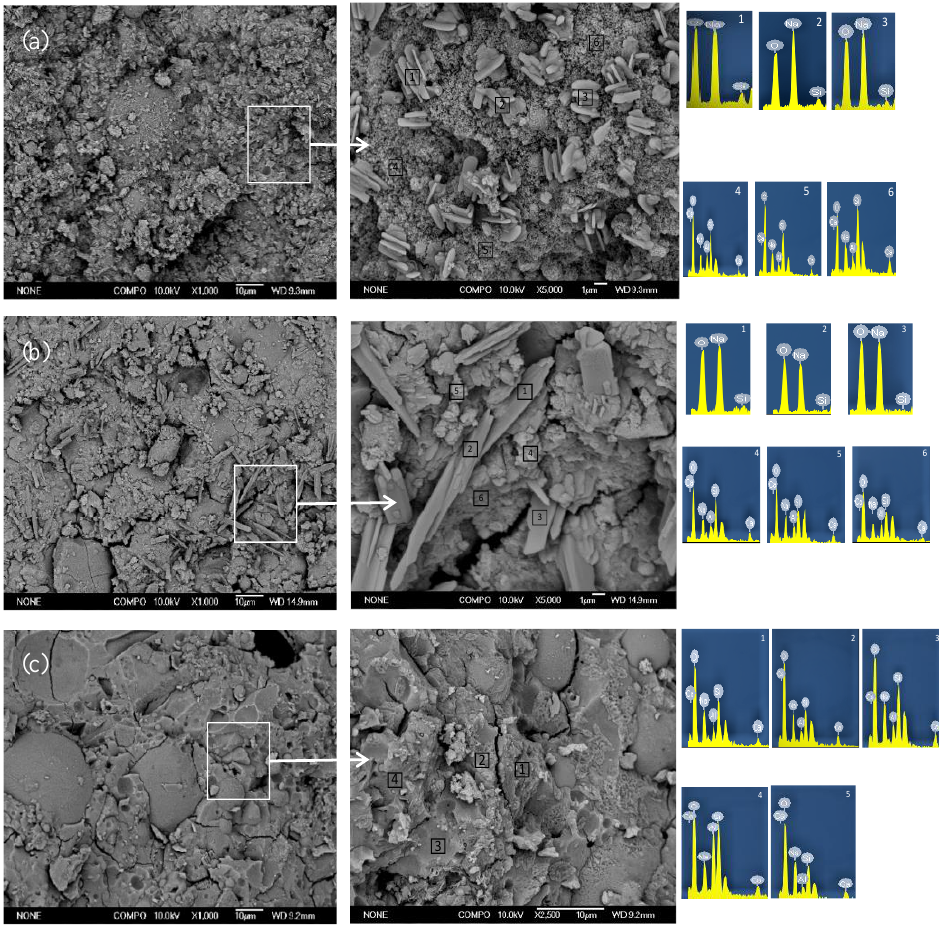
Figure 8. SEM images of samples with different Ms under the C-1 curing conditions after 3 days: ( a ) A-1, ( b ) A-2 and ( c ) A-3.